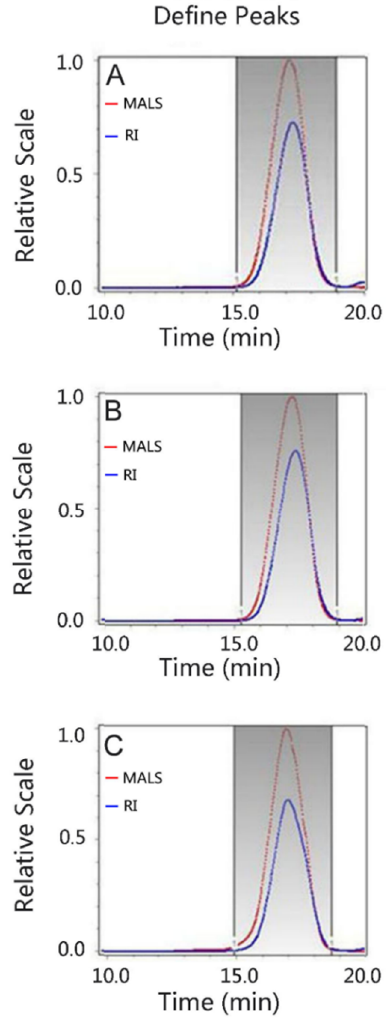
Figure 3. Molecular mass analysis by MALS. The molecular mass of SHCS ( A ), SBCS ( B ), or SFCS ( C ) was measured by size exclusion chromatography with a multi-angle light scattering (MALS) detector and a refractive index (RI) detector, as described under “Section 2”.